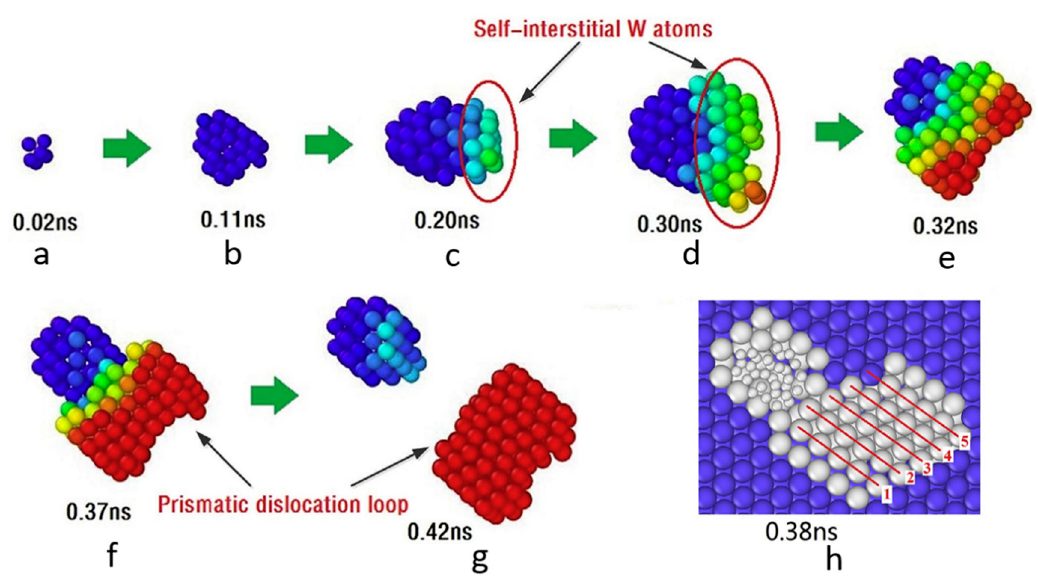
Figure 5. The evolution of He bubble with an initial radius of 0.15 nm. The color from blue to red qualitatively designates the distance from the present atomic site to the center of the He bubble. ( a , b ) Homogeneous bubble nucleation and growth; ( c , d ) self-interstitial tungsten atoms emit from matrix and then attach to the bubble surface; ( e – g ) self-interstitial tungsten atoms evolve into a prismatic dislocation loop and then dissociate from the bubble; and ( h ) the atomic structure of the self-interstitial atom cluster. Reprinted with permission from [49]; Copyright 2017 Elsevier.